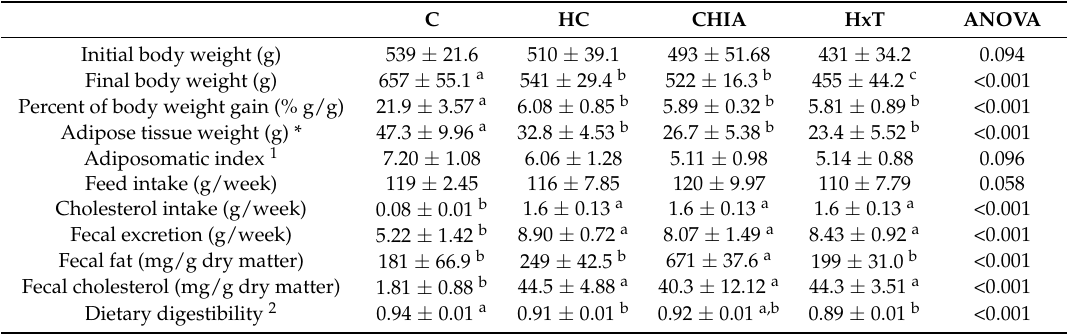
Table 2. Feed intake, body weight, adipose tissue weight, fecal and cholesterol excretion, and dietary digestibility.